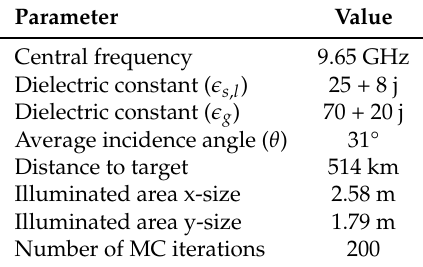
Table 1. Input parameters that are assumed constant during the EM model and PCE EM metamodel